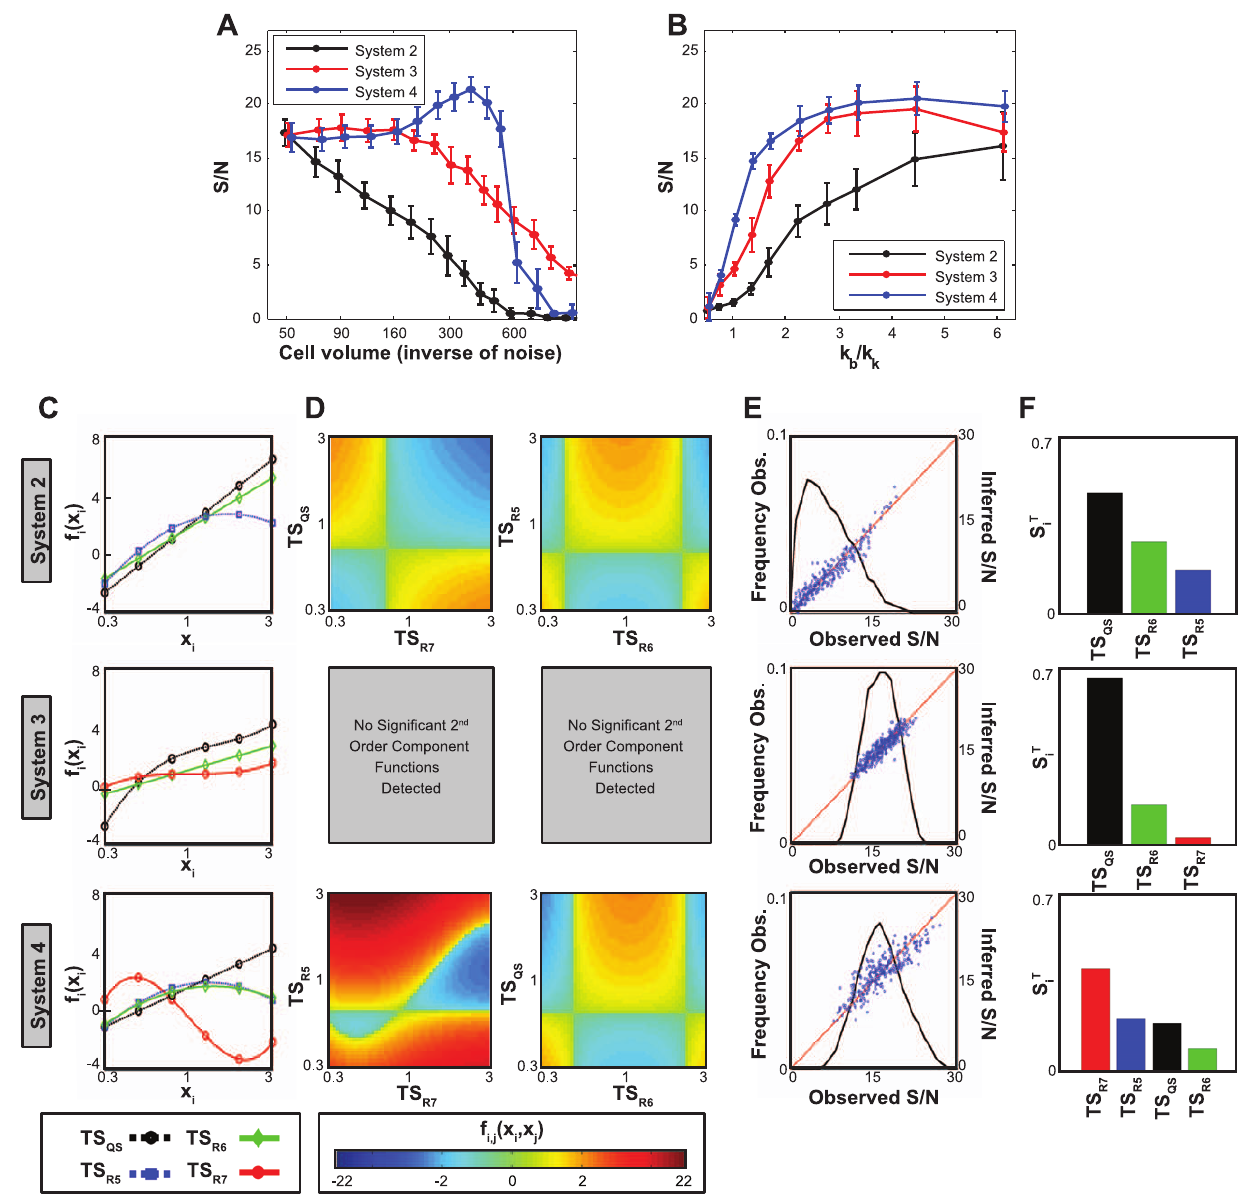
Figure 5. Robustness analyses and time-scale optimization for Systems 2–4. (A) S/N for different cell volume V , which corresponds to the number of molecules in each cell. (B) S/N for different ratios of stem cell division rate ( k b ) and b -cell killing rate ( k k ). (C–D) RS-HDMR analysis of Systems 2–4 to changes in the reaction time-scales of module components. (C) First- and (D) second-order RS-HDMR component functions describe the relationship between reaction time-scales (normalized to [0,1]) and the corresponding S/N observed in the overall system. (E) Distribution of S/N observed in response to time-scale parameter sampling (black) and RS-HDMR inference accuracy of that variation (blue). (F) Total sensitivity indices ) of the module time-scales observed for each system. ( S T i